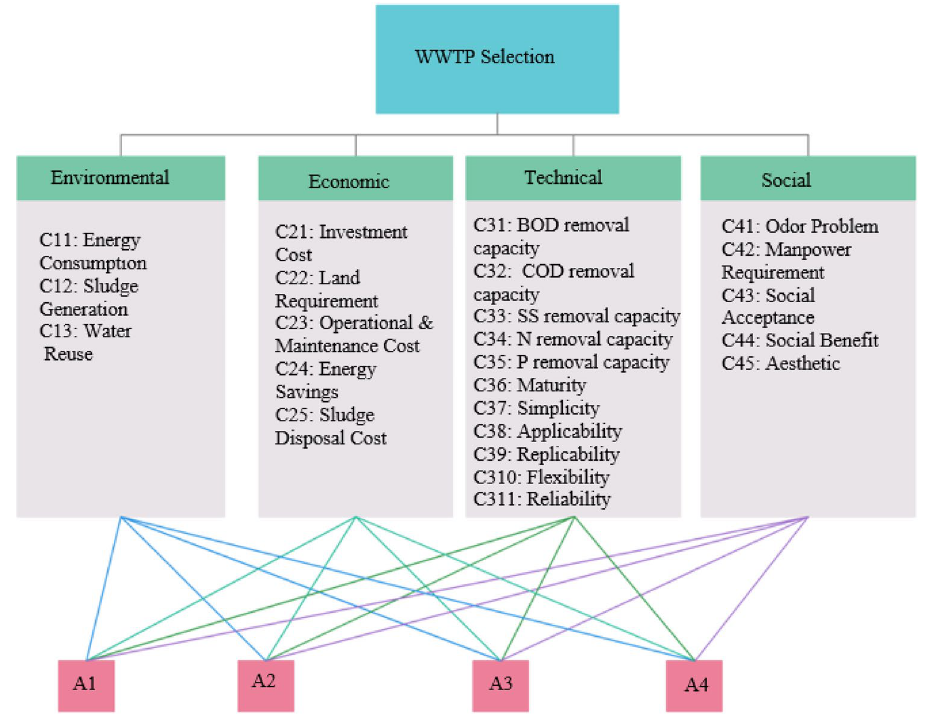
Figure 1. Establishment of criteria system for WWTP